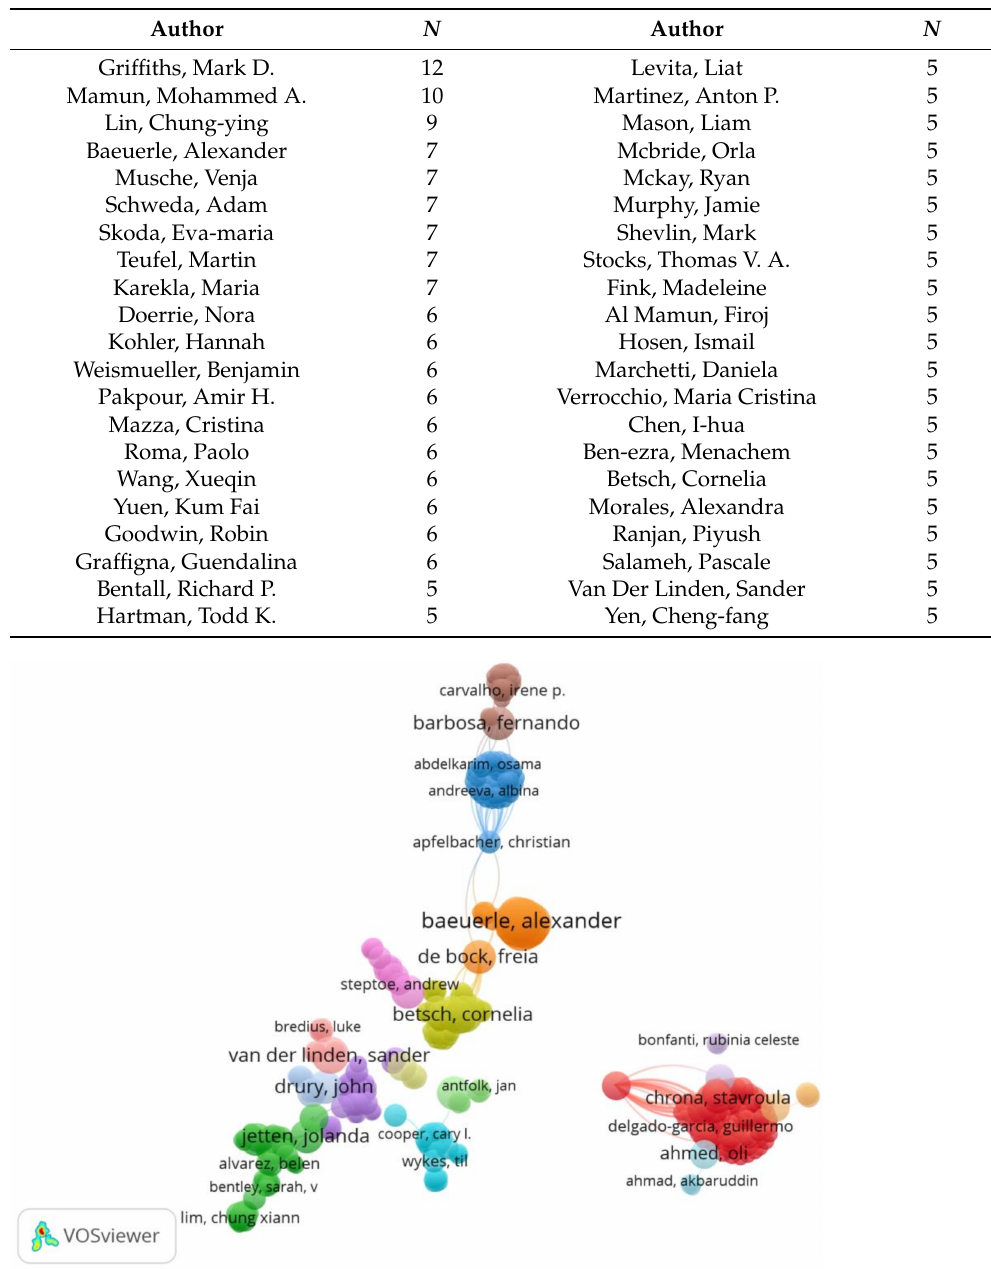
Table 3. Authors of publishing at least 5 articles.